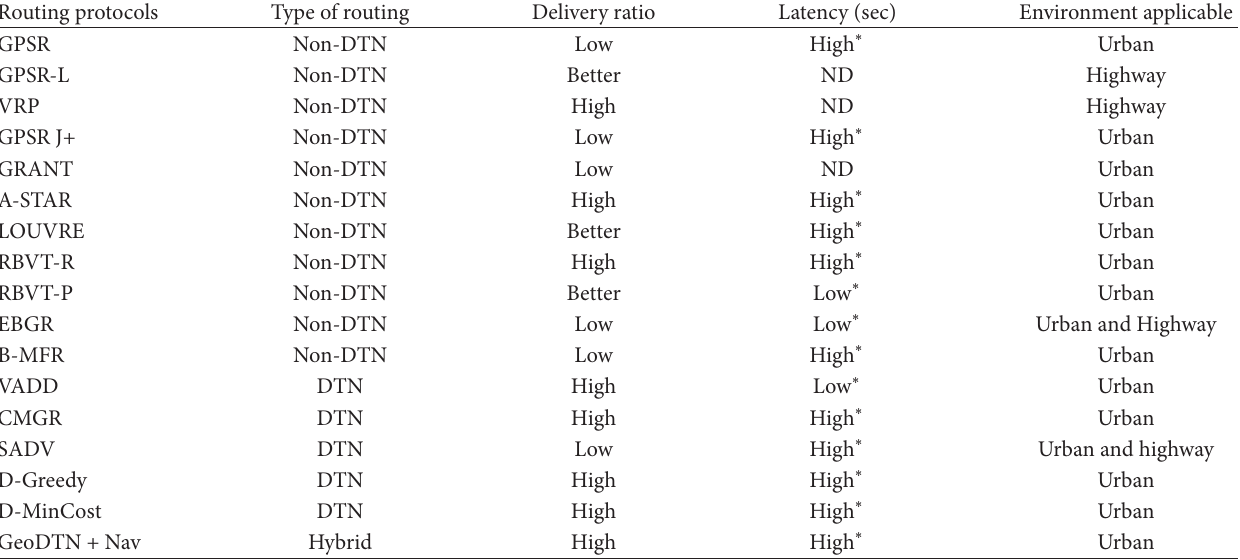
Table 1: Comparison of routing